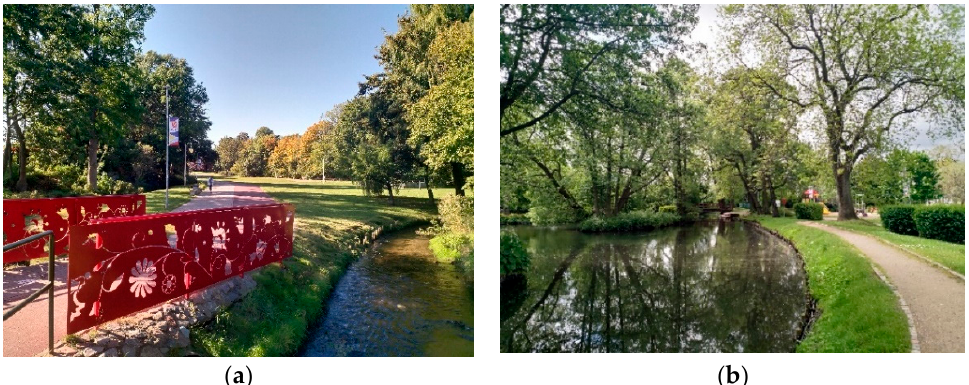
Figure 12. ( a ) There are some points of interest to facilitate the creation of mental maps and wayfind- ing. The bridge railing cutouts resemble the Kashubian embroidery style. Source: author; ( b ) The paths in the park are comfortable, have even surfaces, and provide interesting views with long vistas.